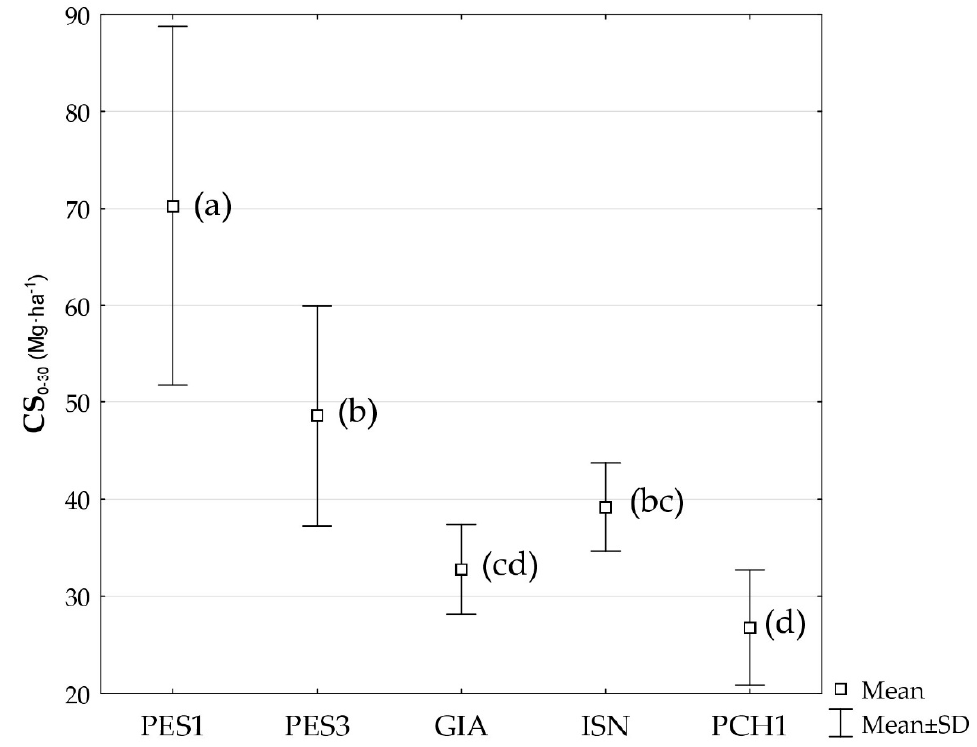
Figure 9. Mean carbon stock (0–30 cm, in Mg · ha − 1 ) of the five soil typologies (STU). The letters define homogeneous groups after Fisher’s LSD test, for p < 0.01.